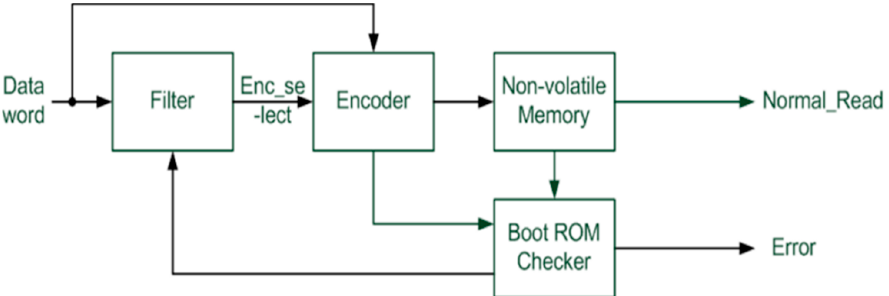
Figure 5. The architecture of the proposed two-dimensional parity with variable length error detection code (2D-VLEDC).